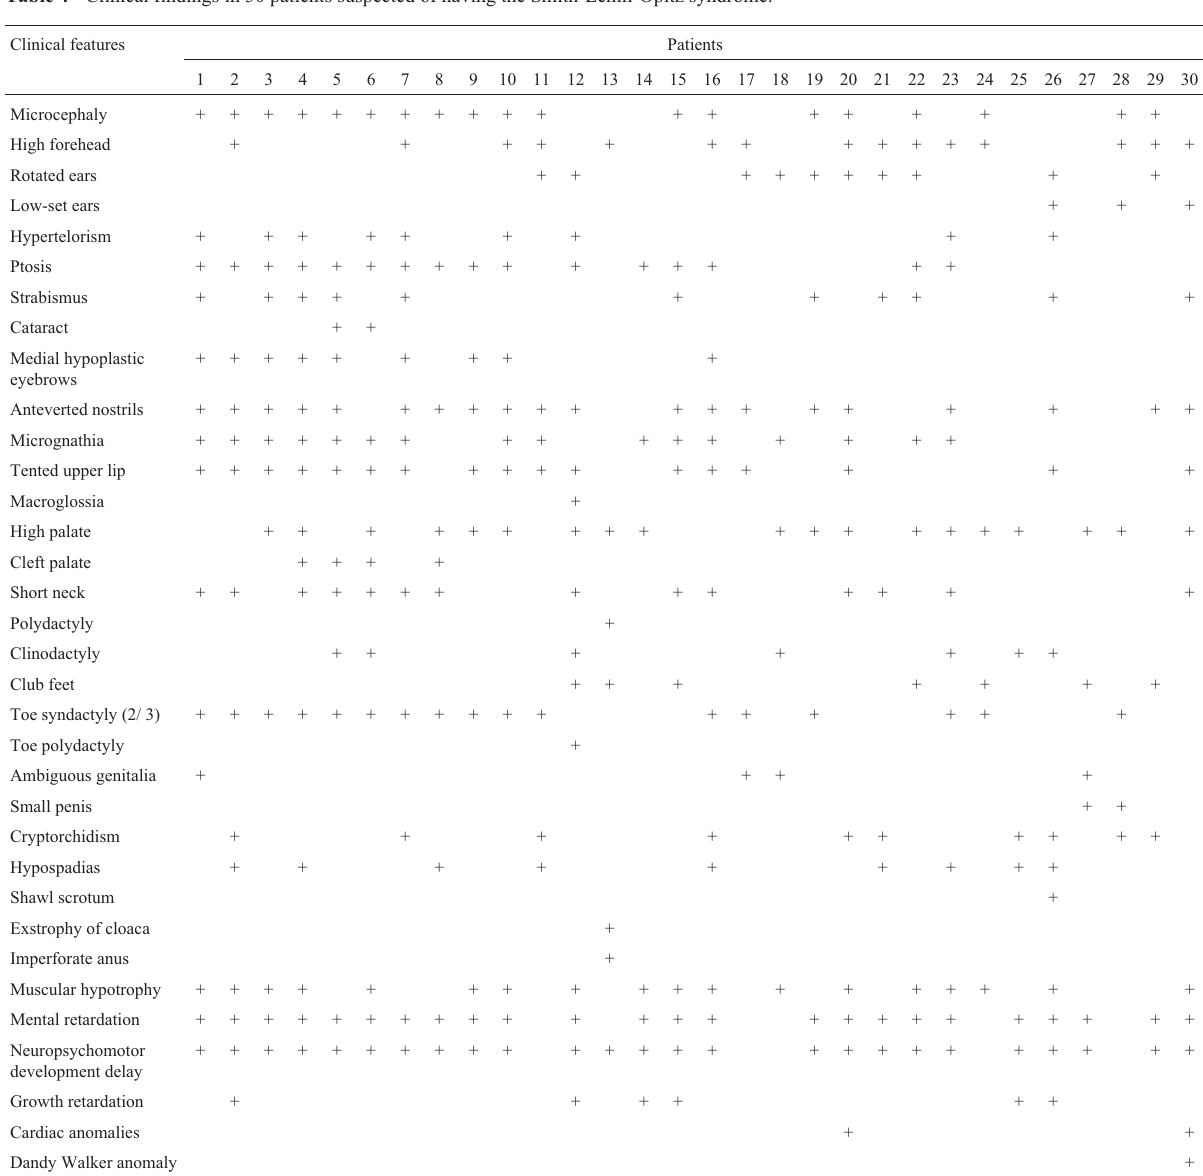
Table 4 - Clinical findings in 30 patients suspected of having the Smith-Lemli-Opitz syndrome. Clinical